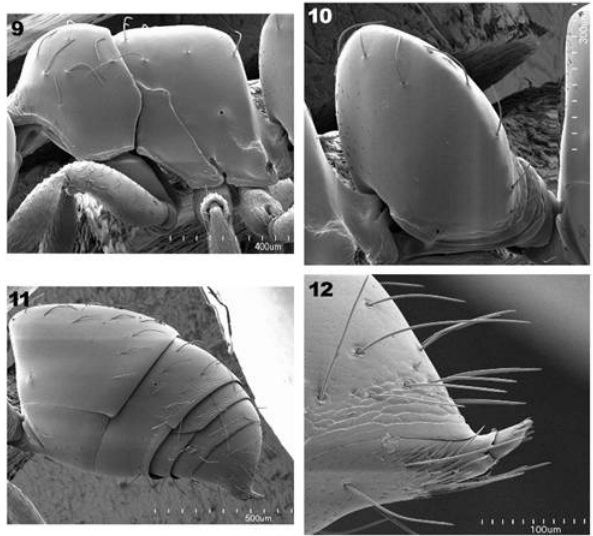
R. Keller. Fig. 5: head with detail of mouthparts, antero-ventral view. Fig. 6: head, anterior view. Fig. 7: Head with details of eye and gena, left lateral view. Fig. 8: Head (partial) with detail of mandibles shape, dorsal view.